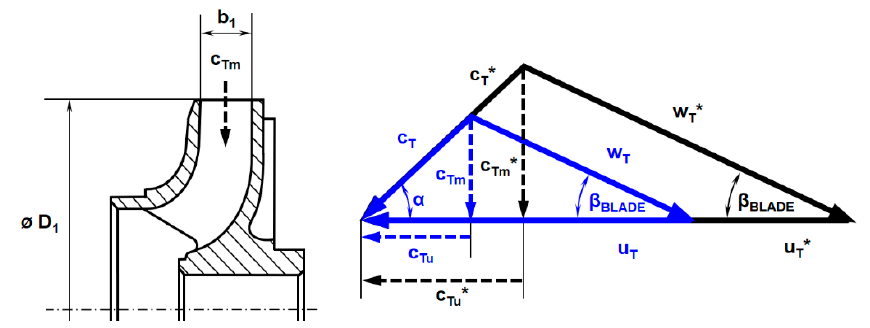
Figure 2. The change of kinematic conditions during turbine operation.